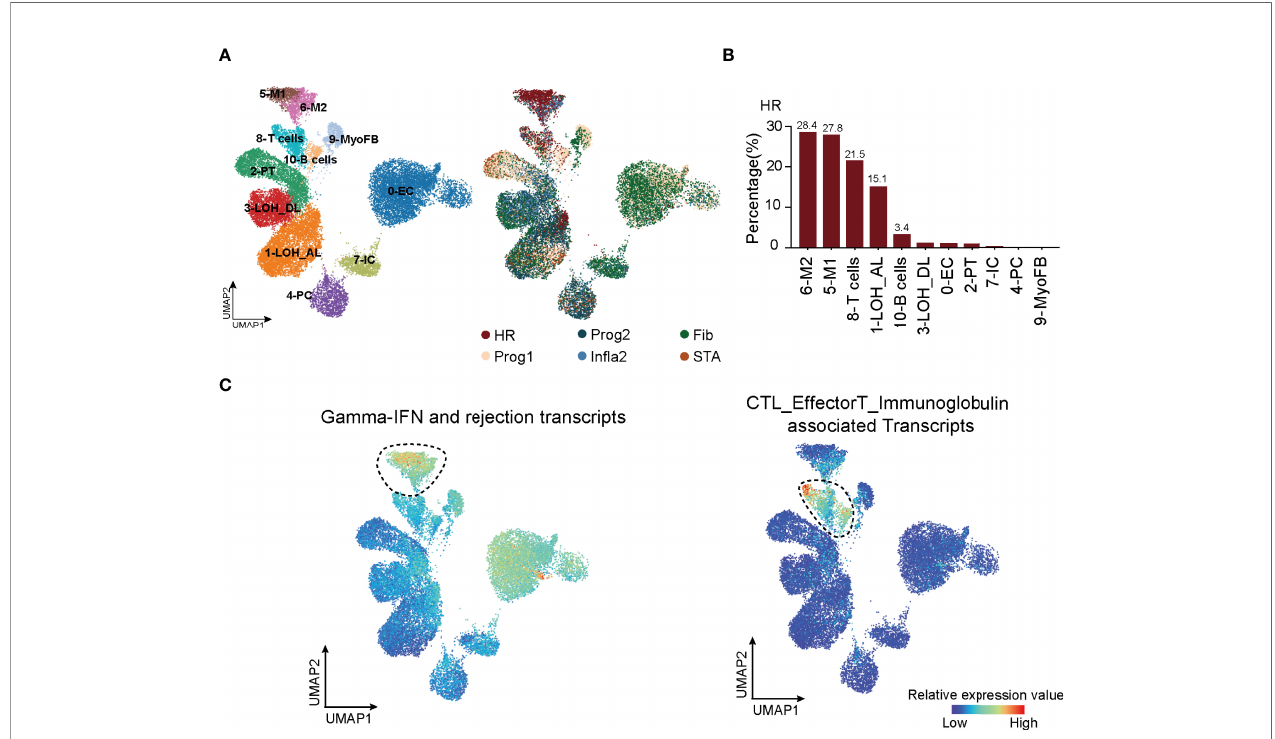
FIGURE 2 | T cells are recruited in triggering HR rejection. (A) UMAP plot showing all cell clusters and their annotations in the atlas (left panel) and the corresponding rejection state (right panel). LOH_AL, loop of Henle, ascending limb; LOH_DL, loop of Henle, distal limb; Endo, endothelial cell; PT, proximal tubule; PC, principal cell; MyoFB, myo fi broblast; IC, intercalated cell. (B) The proportion of various clusters of cells in each rejection state. (C) Enrichment of transcripts presenting high risk of graft failure in immune cell types. HR, high-risk state; Prog1, progressive state 1; Prog2, progressive state2; In fl a2, in fl ammatory state 2; STA, stable state; Fib, fi brosis